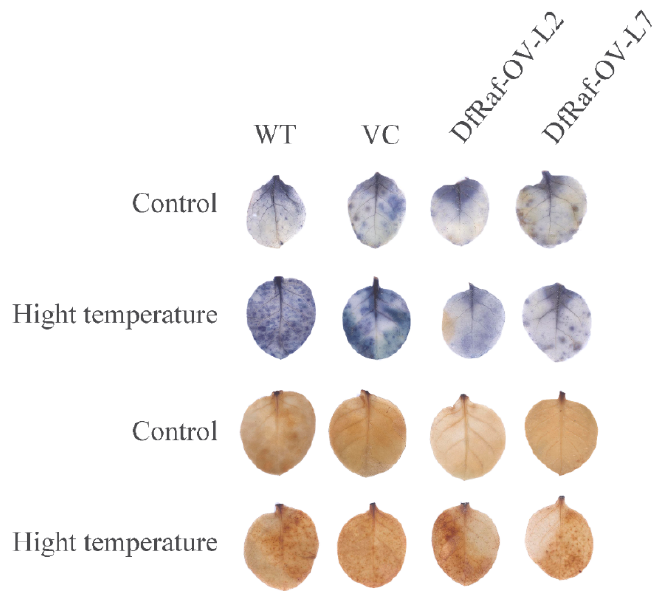
Figure 9. DAB and NBT staining of tolerant leaves under high-temperature stress.